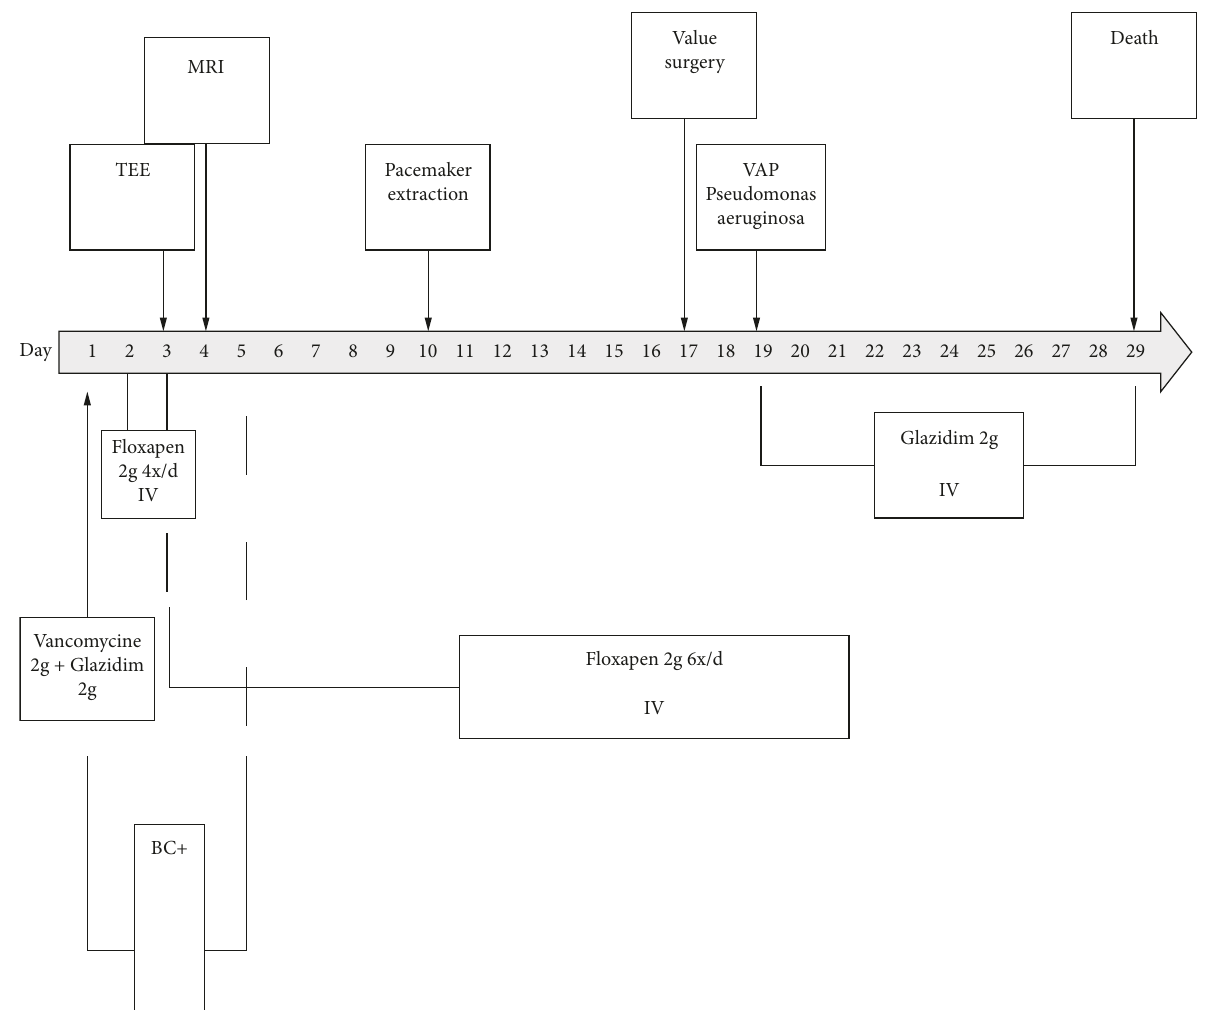
Figure 2: Time line of clinical course, diagnostics, interventions, and outcomes. BC: blood culture, TEE: transoesophageal echography, MRI: magnetic resonance imaging, and VAP: ventilator-associated